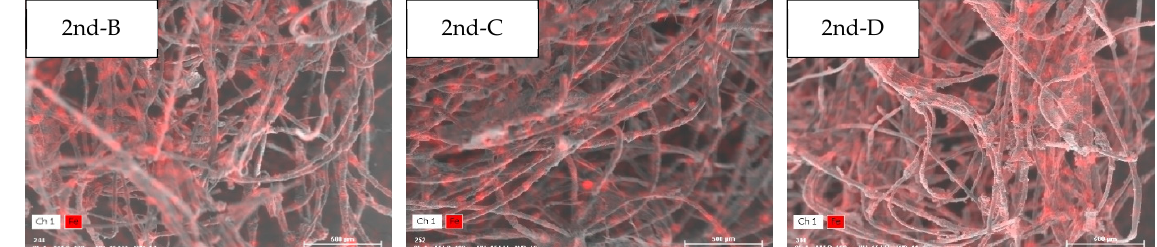
Table 6. Weight ratio for each major element of the return air, using SEM-EDS, on June 28.